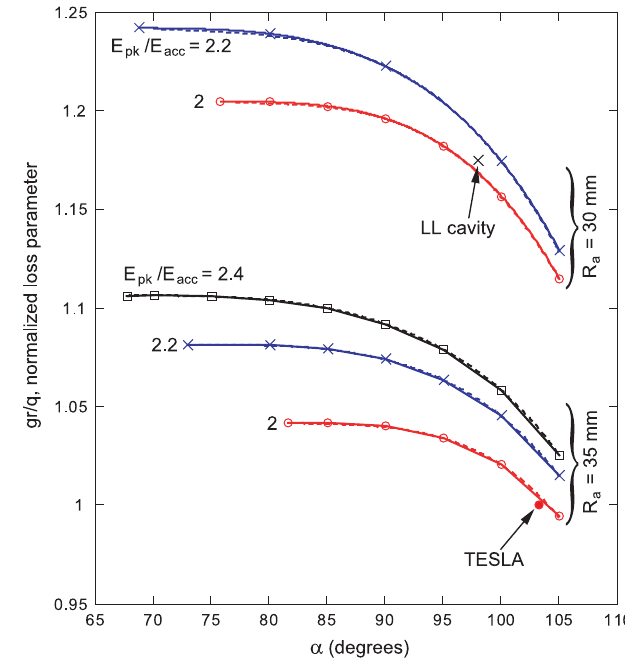
FIG. 3. (Color) Normalized loss parameter for different angles of slope. Solid lines are for max G (cid:1) R sh =Q , dashed lines are for minimal h . (Graphically both lines nearly